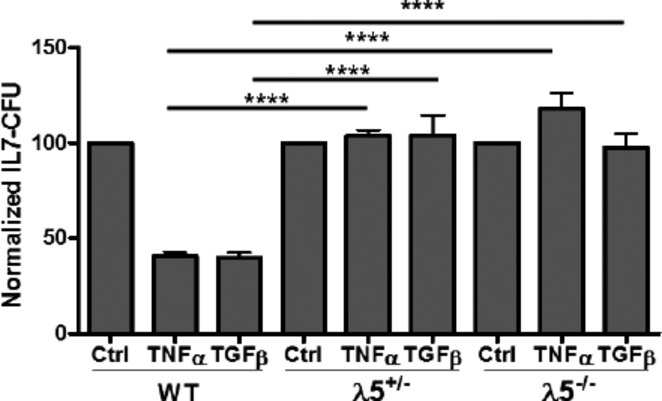
Low λ5 increases survival in pro-B cells challenged with either TNFα or TGFβ. Unfractionated bone marrow cells (1 × 106 ml−1) from wild-type (WT), λ5 heterozygous deficient, or λ5-homozygous-deficient 2- to 3-month-old B6 mice were cultured with either 10 ng ml−1 rmTNFα or 10 ng ml−1 rmTGFβ in IL-7 CFU assays. Colonies were counted at 8 days. Normalized IL-7 CFU values were obtained in 6–12 individual experiments. Statistical significance (two-tailed Student's t-test): ****, P < 0.0001.